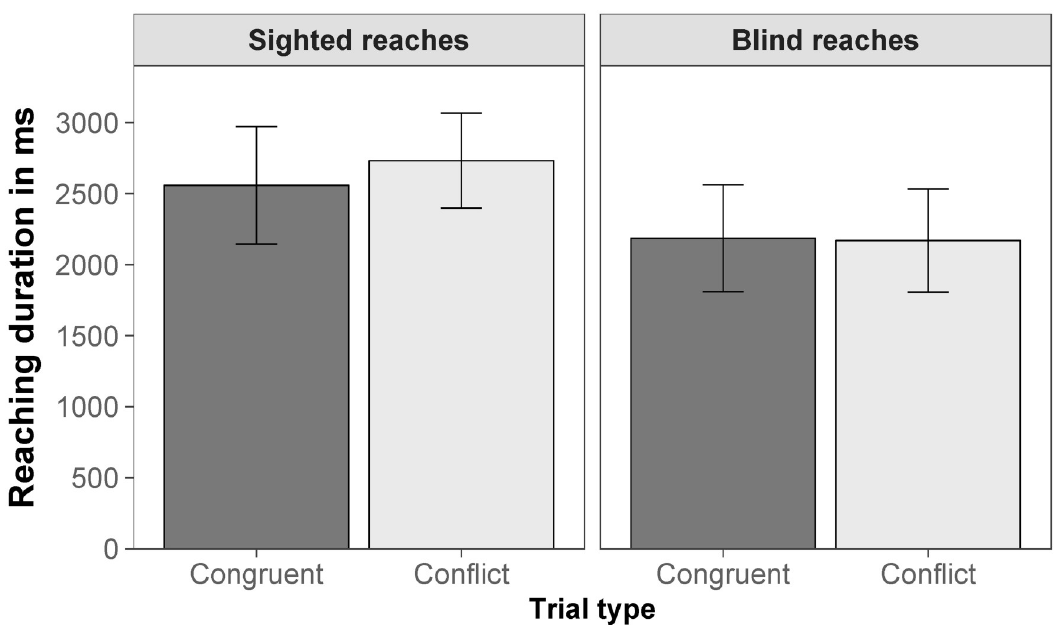
Fig 7. Reaching duration. Mean reaching duration for sighted reaches (left) and blind reaches (right) for congruent trials (disparity- specified distance corresponded to familiar size-specified distance; dark gray) and conflict trials (disparity-specified distance was opposed to familiar size-specified distance; light gray) of the by-subject aggregated data. Error bars are within-subjects 95% confidence intervals according to Morey [69].